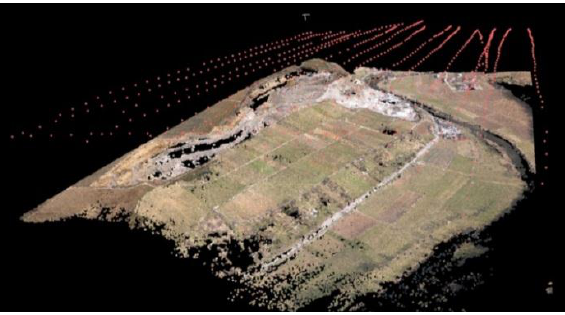
Figure 5. Sparse point cloud and camera stations (red) for an image dataset acquired by an UAV